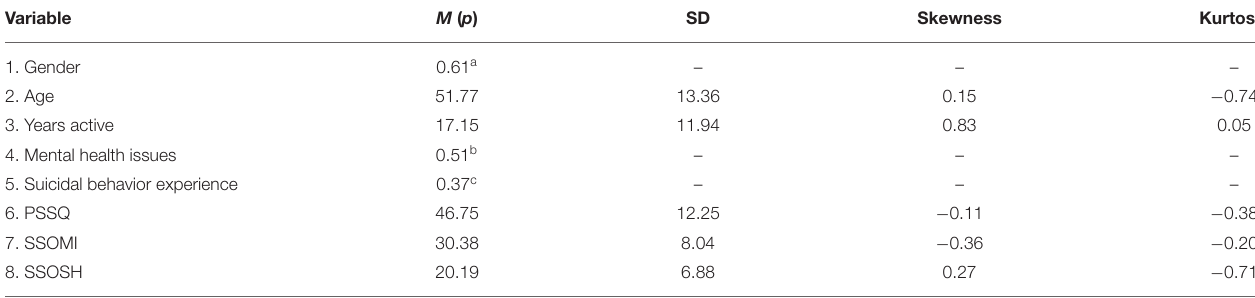
TABLE 1 | Descriptive statistics for the examined variables ( N = 83). Variable